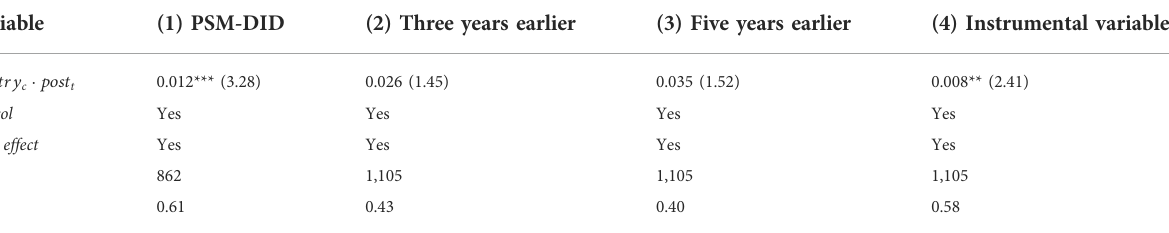
TABLE 4 Results of the robustness test.